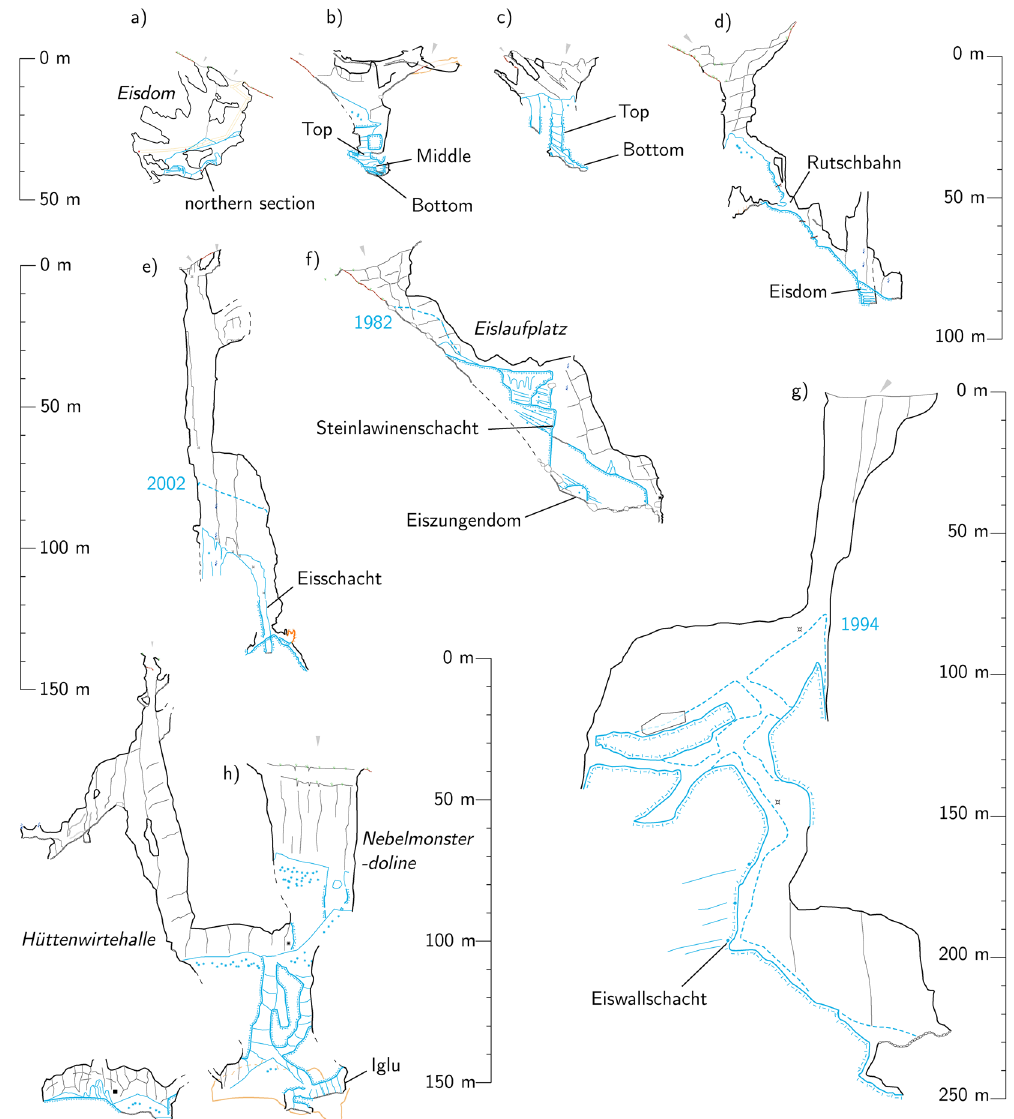
Eisgruben Eishöhle, ( g ) Kraterschacht, redrawn after Weißmair et al. 35 ( h ) Hochschneid Eishöhle, redrawn after Wielander et al. 62 . Steepled blue lines denote snow or firn levels recorded